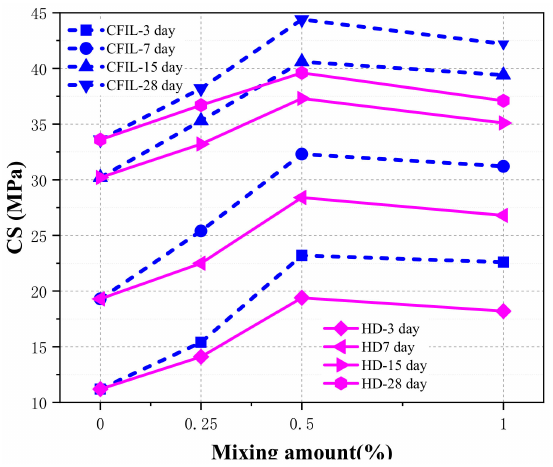
Figure 6. Relationship between CS and mixing